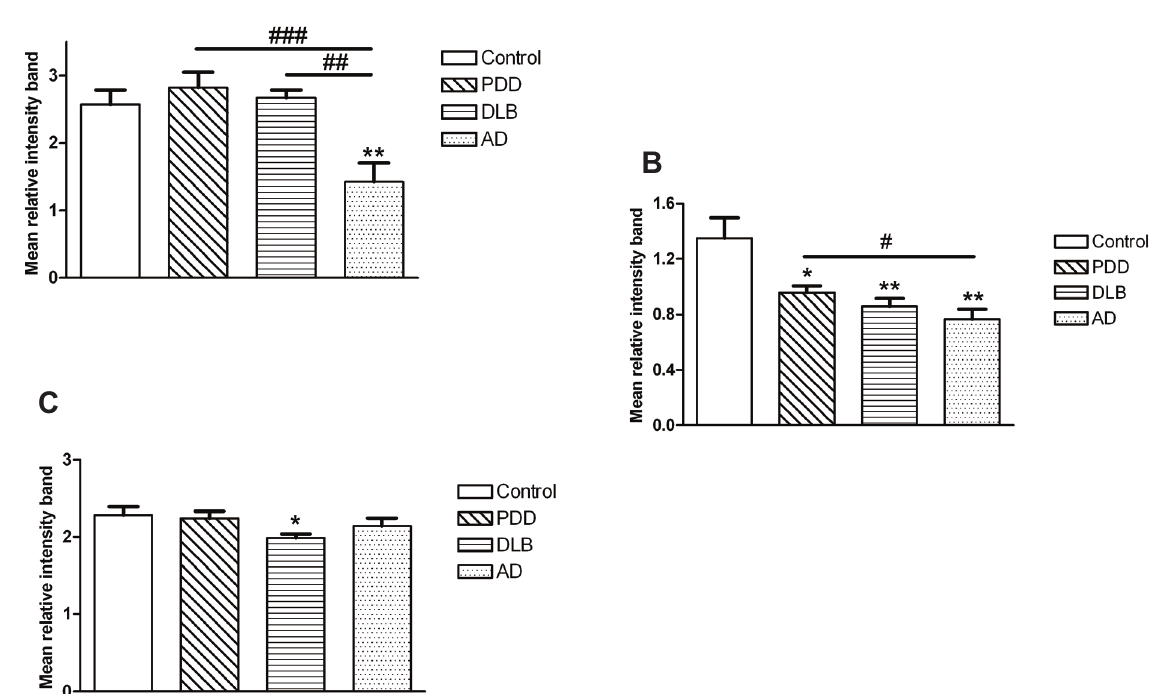
Figure 2. Fraction of phophoCaMKII levels measured by Western blot in BA9, BA24 and BA40 tissues from subjects with PDD, DLB, AD and controls. ( A ) BA9, ( B ) BA24 and ( C ) BA40. Bars represent mean of ratio phospho/totalCaMKII and error bars SEM. ** (p<0.05) and ** (p<0.01) compared to controls, # (p<0.05), ## (p<0.01) and ### (p<0.001) between dementia groups. Table 2. Total and phospho-CaMKII levels measured by Western blot in BA9, BA24 and BA40 tissues from subjects with PDD, DLB, AD and controls. Values represent the means of relative intensity